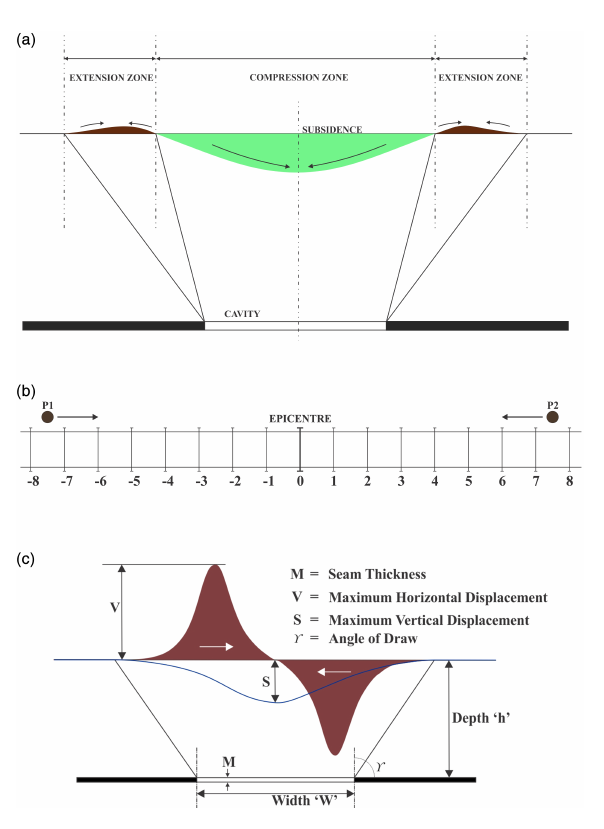
Figure 5. (a) Compression and Extension zones during Subsidence (NCB, 1975; Whittaker and Reddish, 1989). (b) Movement of ma- terials around the epicentre of subsidence. (c) Empirical Subsidence Model (NCB, 1975; Whittaker and Reddish,